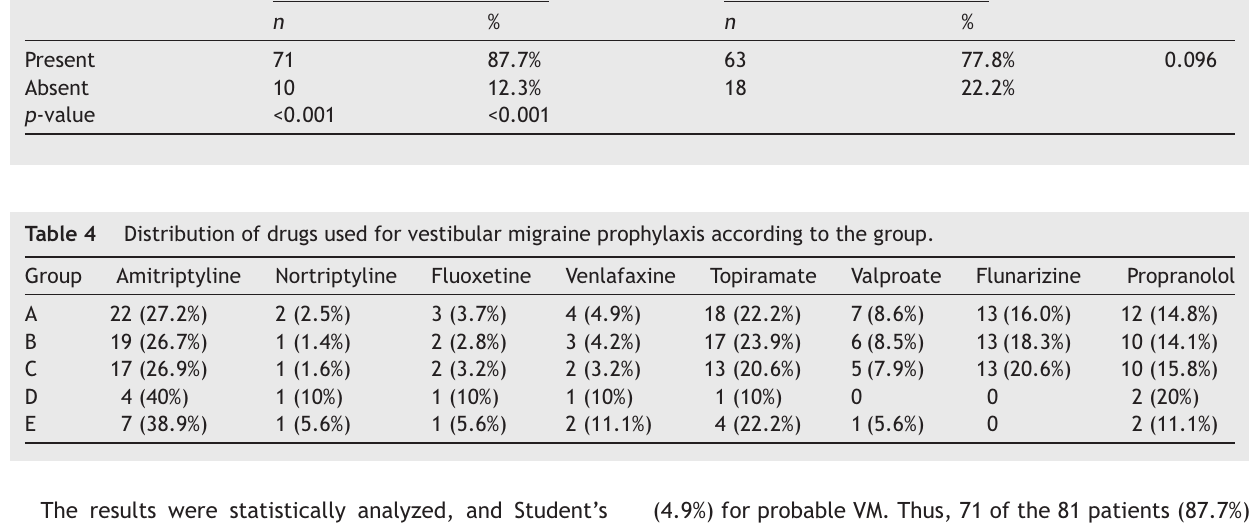
Distribution of vestibular migraine outpatients according to former and current diagnostic criteria. Criteria